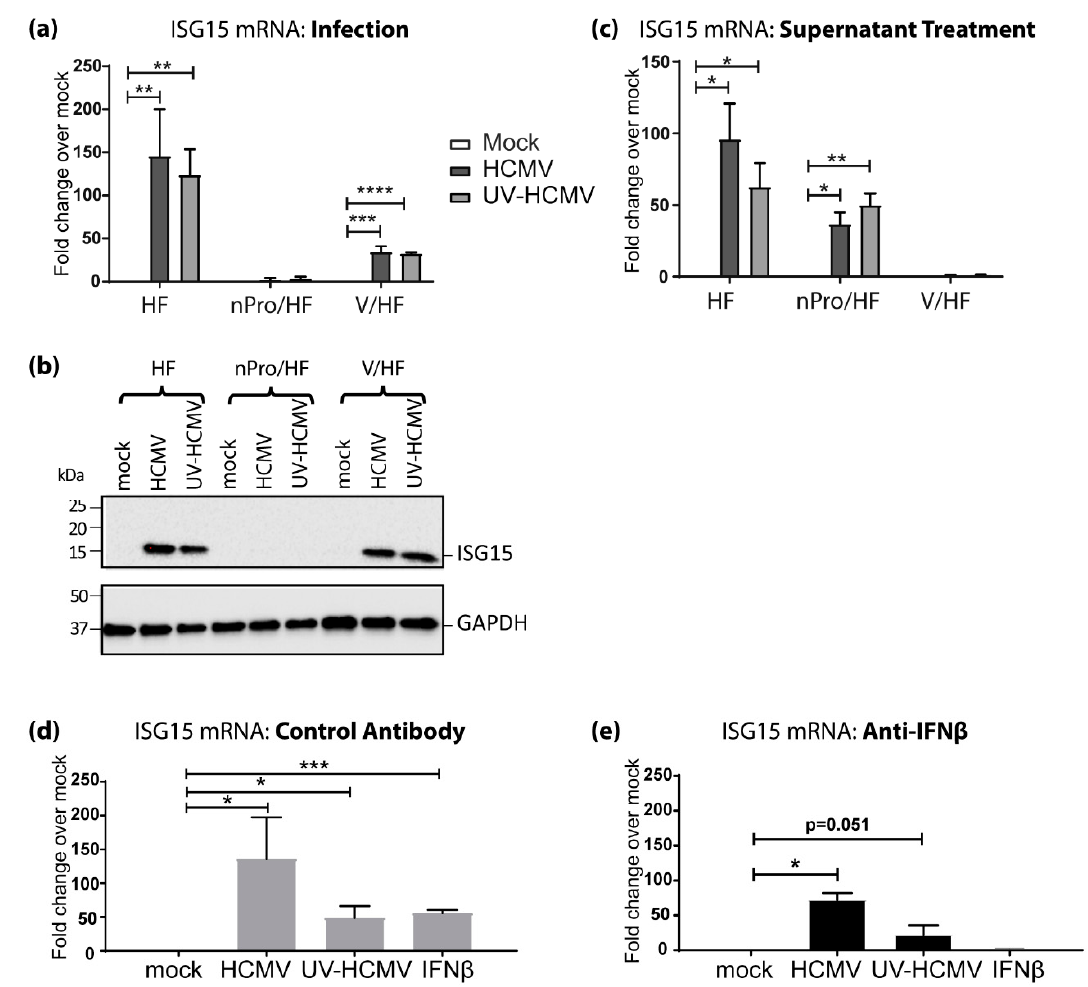
Figure 2. IRF3-dependent, STAT1-independent regulation of ISG15 following HCMV infection ( a ) Primary HFs, nPro/HFs and V/HFs were infected at an MOI of 3 with HCMV or UV-HCMV and levels of ISG15 transcript were analyzed 6 h.p.i as in Figure 1. ( b ) Primary HFs, nPro/HFs and V/HFs were infected at an MOI of 3 with HCMV or UV-HCMV. Protein lysates were harvested at 24 h.p.i. and analyzed by immunoblot, staining for ISG15 and GAPDH. ( c ) Primary HFs, nPro/HFs and V/HFs were treated with filtered (0.1 µ m pore size) supernatant from mock, HCMV or UV-HCMV infected primary HFs. RNA harvested at 6 h post-treatment was analyzed by quantitative reverse transcription polymerase chain reaction (qRT-PCR) as in Figure 1. RNA was extracted at 6 h.p.i. from primary HFs treated with 100 U of IFN β or infected at a multiplicity of infection (MOI) of 3 with HCMV or UV-HCMV in the presence of ( d ) a control antibody or ( e ) IFN β -neutralizing antibody and analyzed by qRT-PCR. Error bars indicate the standard error of the mean (SEM) and statistical significance was calculated using a Student’s two-tailed T-test. n = 3, * p < 0.05, ** p < 0.01, *** p < 0.001, **** p < 0.0001.